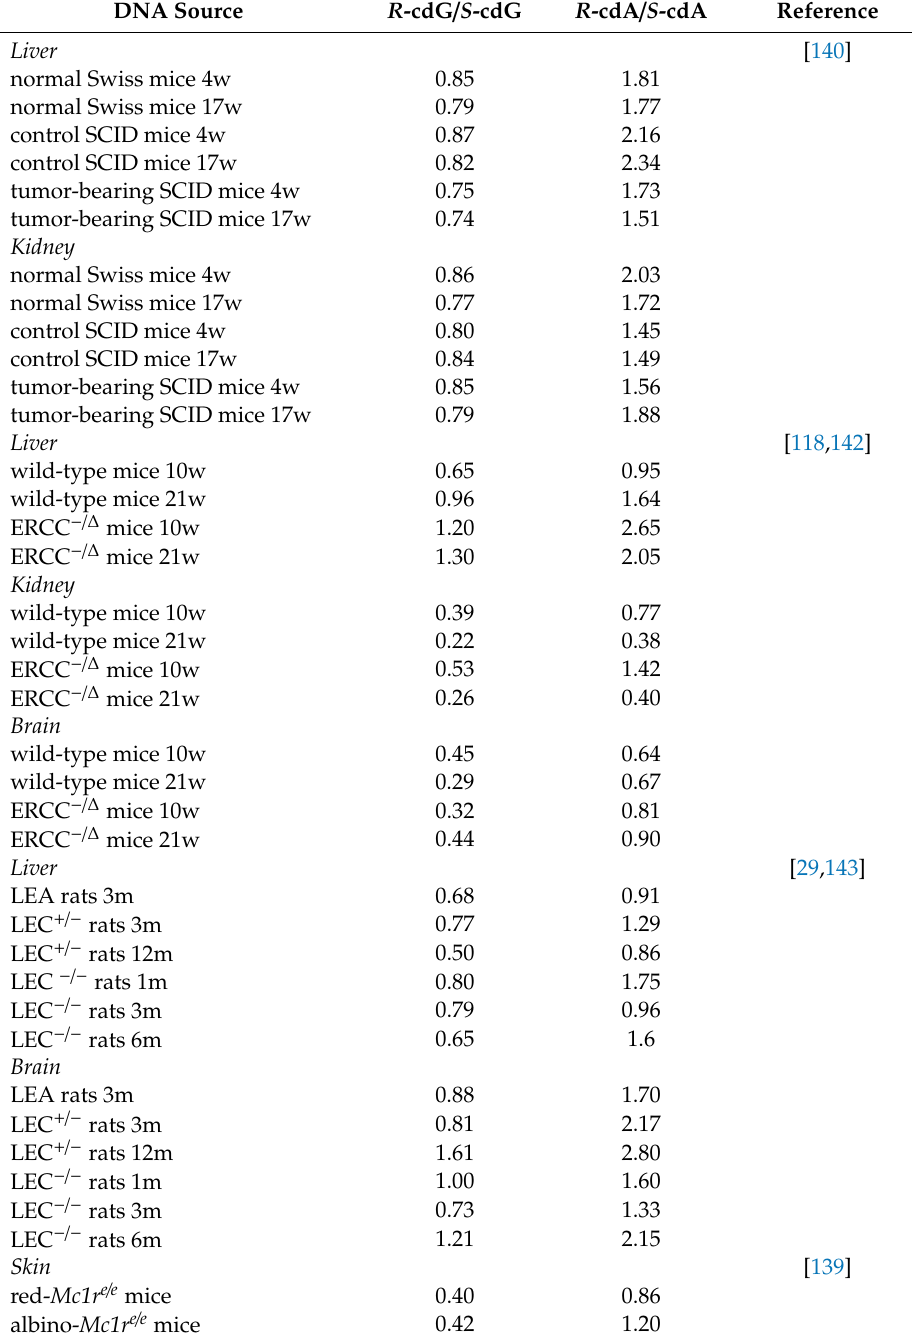
Table 2. Diastereomeric ratios ( R / S ) of cdG and cdA lesions in animal tissues by isotope dilution liquid chromatography–tandem mass spectrometry #